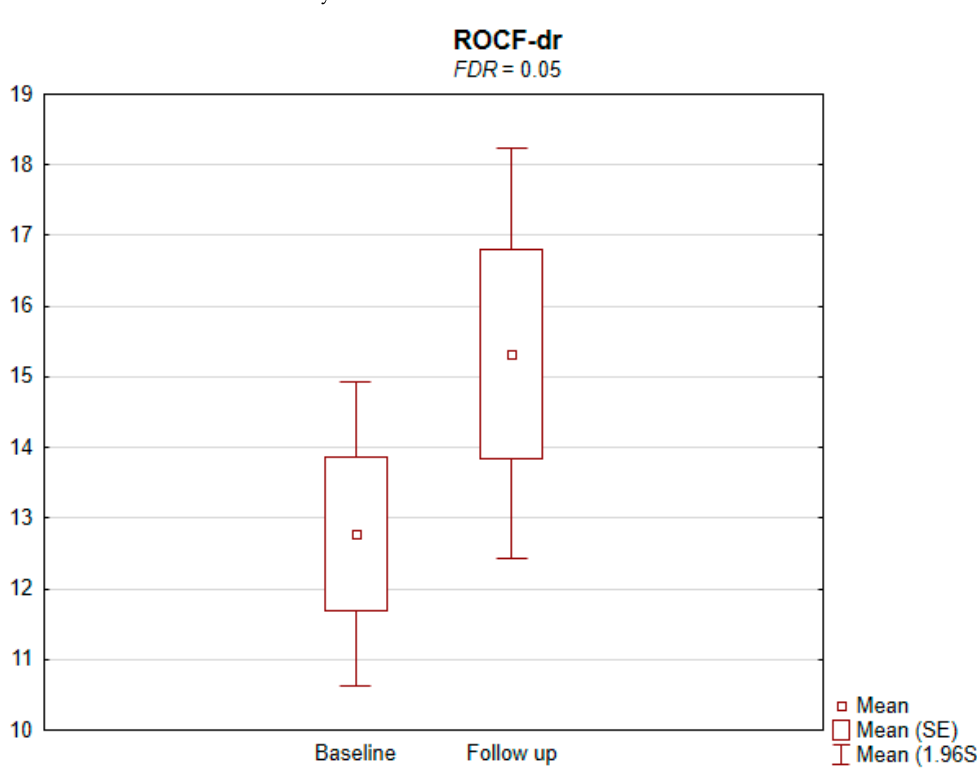
Figure 2. Rey–Osterrieth complex figure delayed recall (ROCF-dr) before and after the intervention. FDR —false discovery rate.